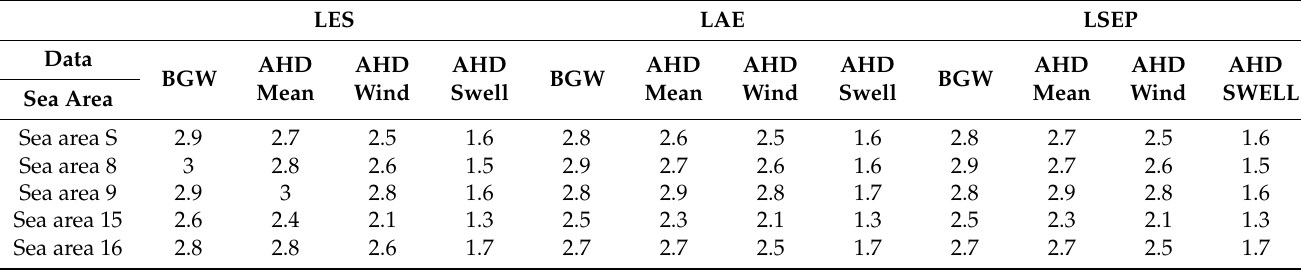
Figure 9. Plots of WST swell sea pdf (sea area S—full year).